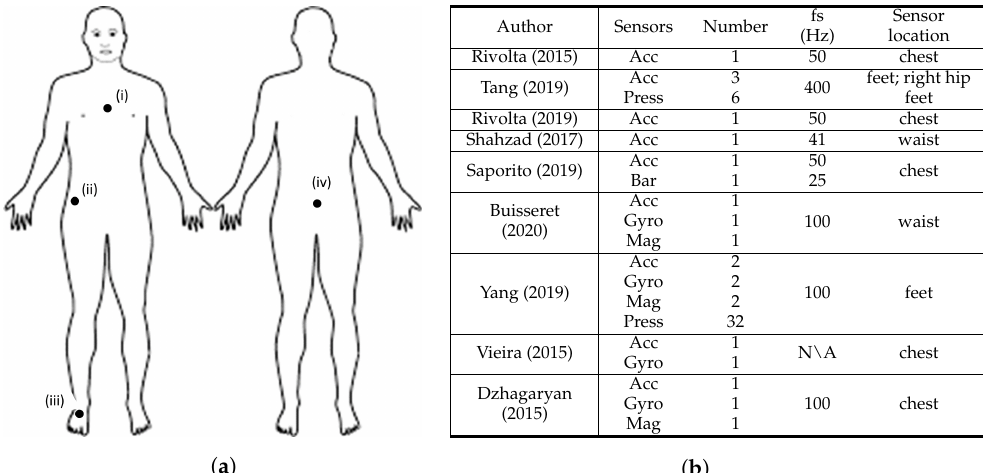
Figure 3. Overview of the sensor characteristics from clinical scale-based fall risk assessment studies. ( a ) Anterior and posterior views of the human body depicting sensor location, where: (i) [8,25,27, 33,34], (ii) [9], (iii) [9,31], and (iv) [26,30]. ( b ) Adopted sensor specifications, where: S = sensors, N = number, fs = sampling frequency, Acc = accelerometer, Gyro = gyroscope, Mag = magnetometer, Press = pressure sensors, Bar = barometer, Dist = distance sensors, N \ A = Not Available. Rivolta [8], Tang [9], Rivolta [25], Shahzad [26], Saporito [27], Buisseret [30], Yang [31], Vieira [33], and Dzhagaryan